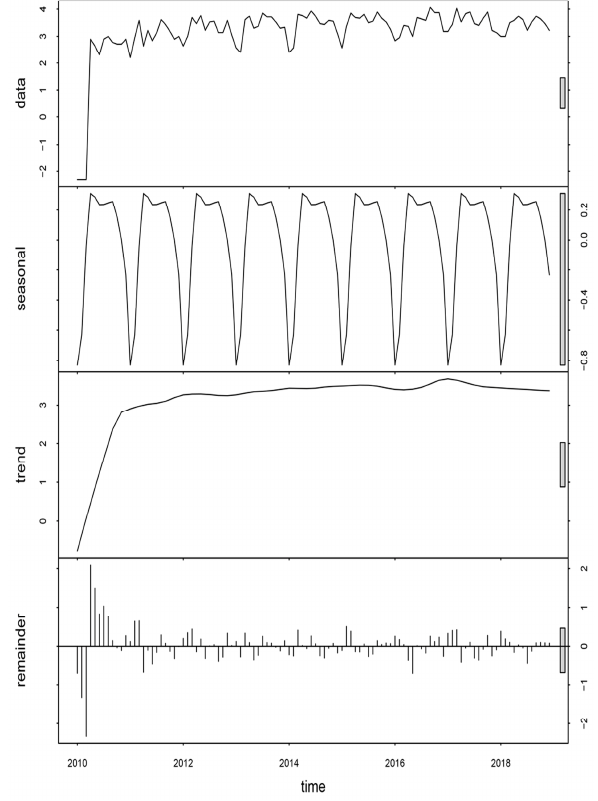
Figure 4. Decomposed tuberculosis cases in the new urban area of Nanchang from 2010 to 2018.